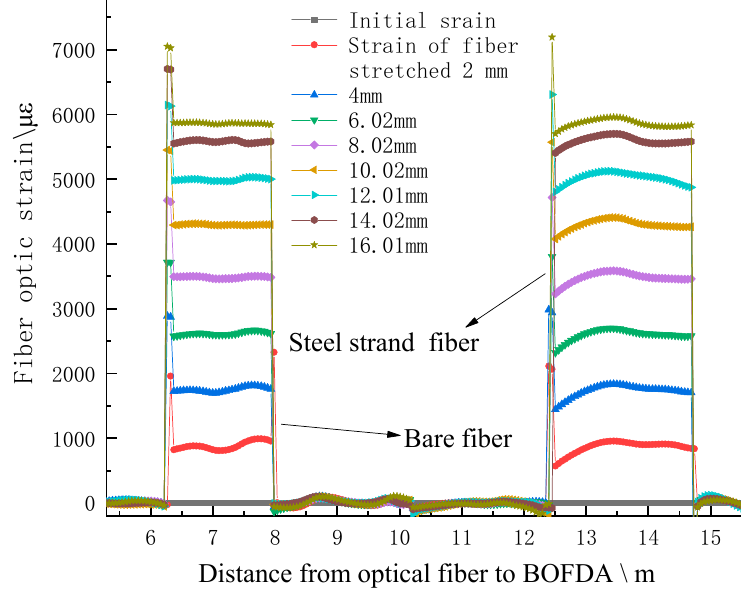
Figure 15. Strain curve of bare fiber and 5-mm steel strand fiber. The strain transfer coefficient is defined in two forms.